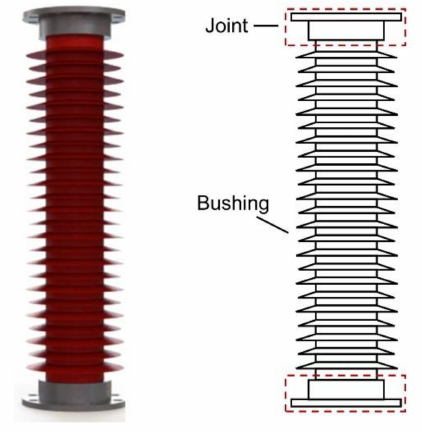
Figure 1. Interconnection between UHV porcelain bushing and flanges.